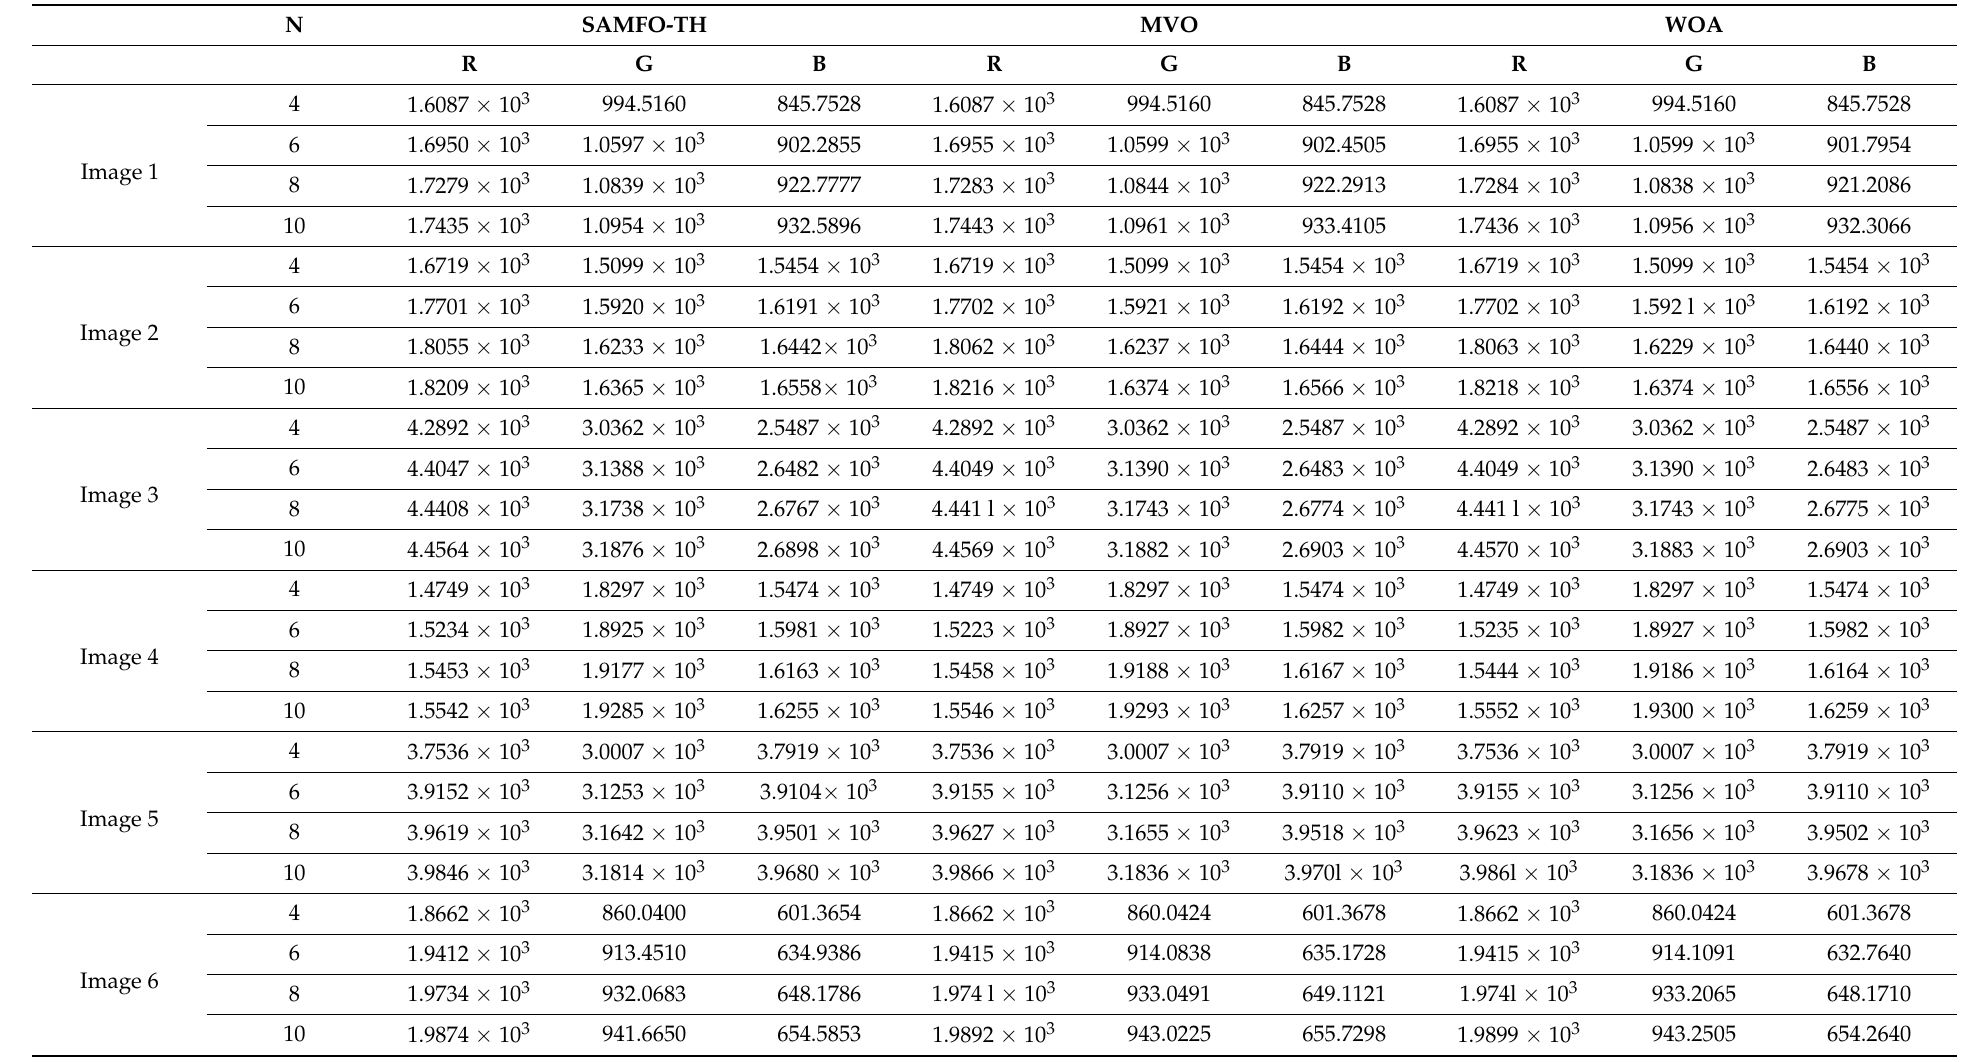
Table 15. Comparison of MEAN computed by SAMFO-TH, MVO, and WOA using Otsu’s method with N = 4, 6, 8, and 10 for red, green, and blue